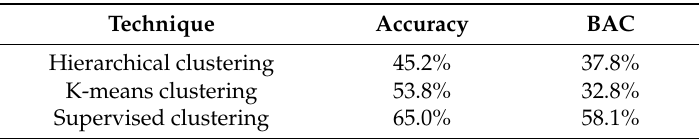
Table 4. Classification